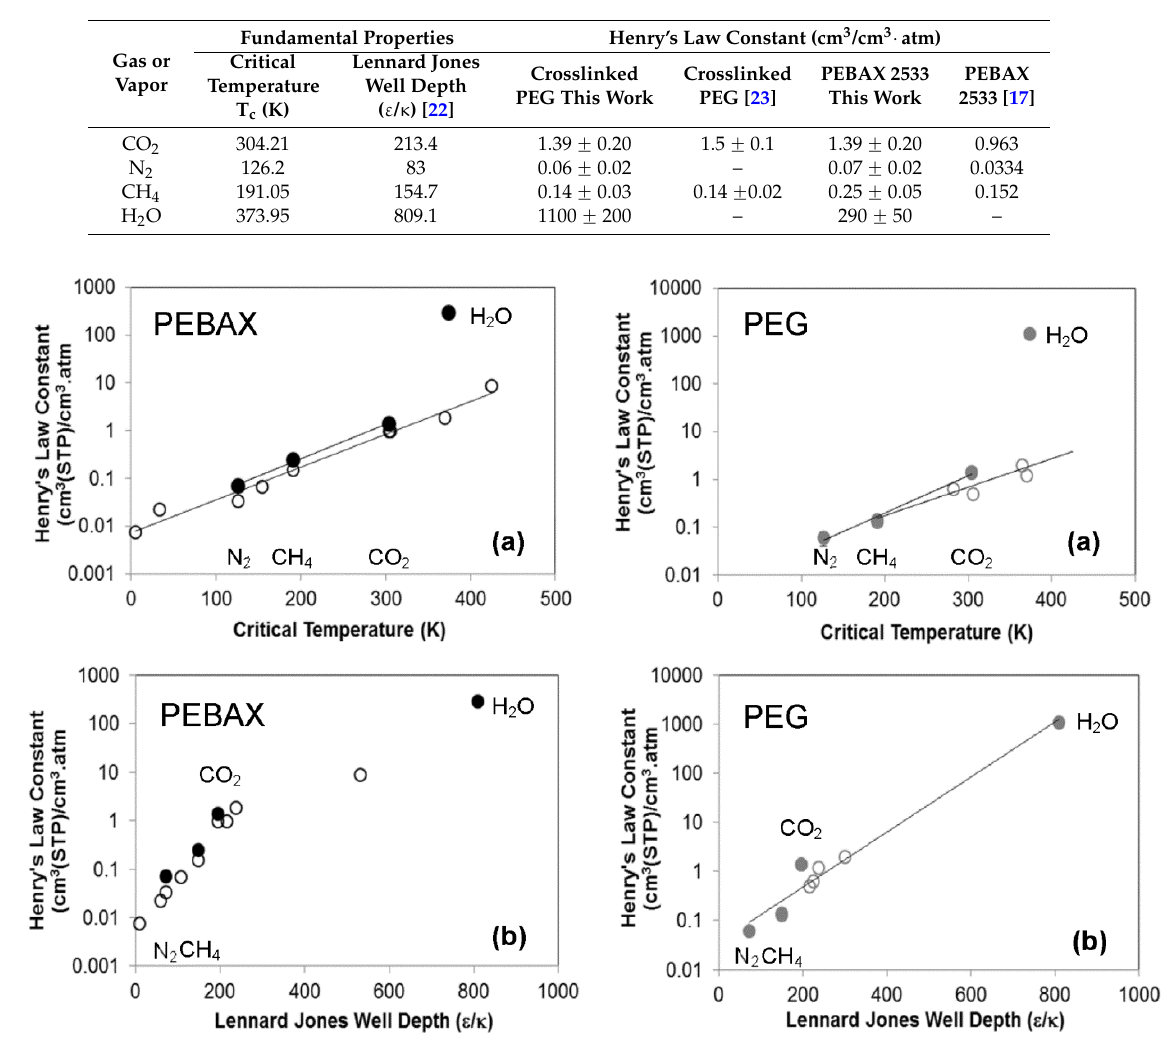
Figure 2. Correlation between the infinite dilution solubility or Henry’s Law constant at 35 °C and the ( a ) Critical Temperature and ( b ) Lennard Jones Well Depth ( ε / κ ) of a range of penetrants for PEBAX(black) and PEG (grey). Filled symbols are the data from this work, while the open symbols are data from Bondar et al. [17] (PEBAX) and Lin and Freeman [18] (PEG).